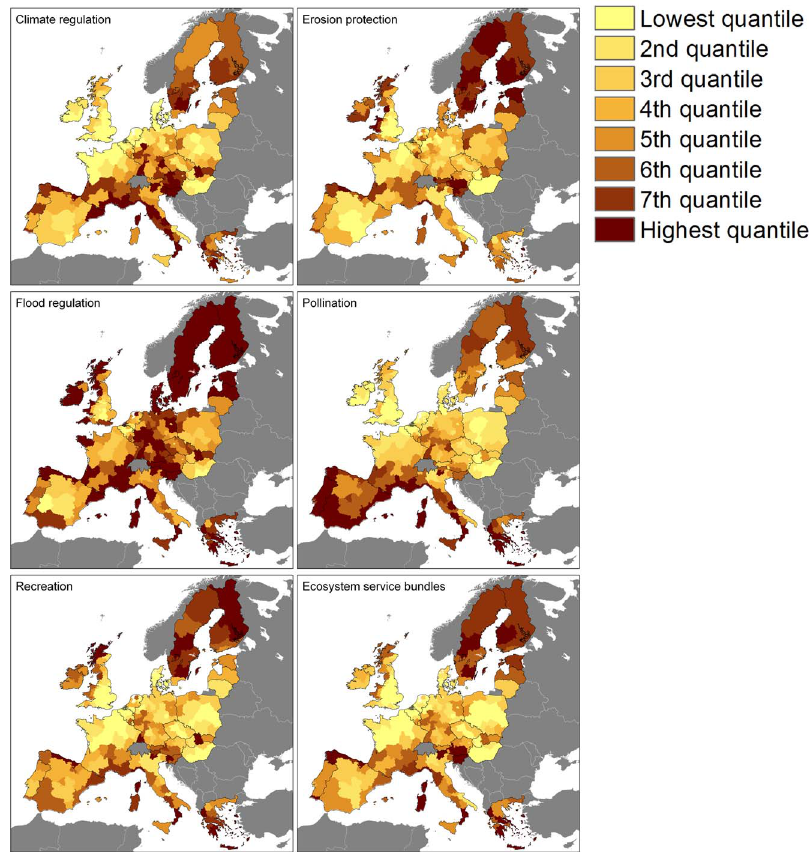
Figure 3. Mean ecosystem service provision per NUTS2 region. Dark grey areas were not considered.